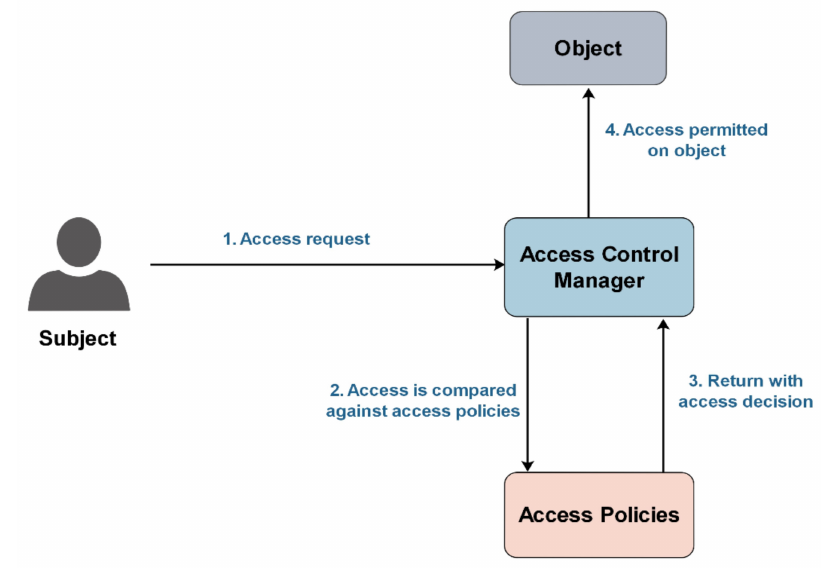
Figure 1. Flow of an access control